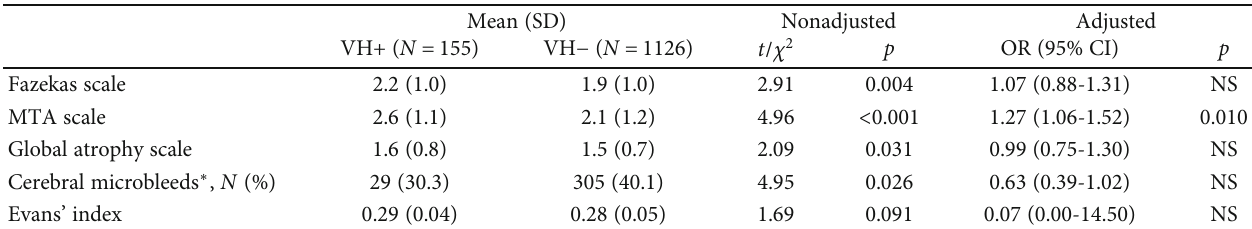
Table 3: Cerebral CT/MRI manifestation of VCI patients with or without visual hallucinations (VHs).